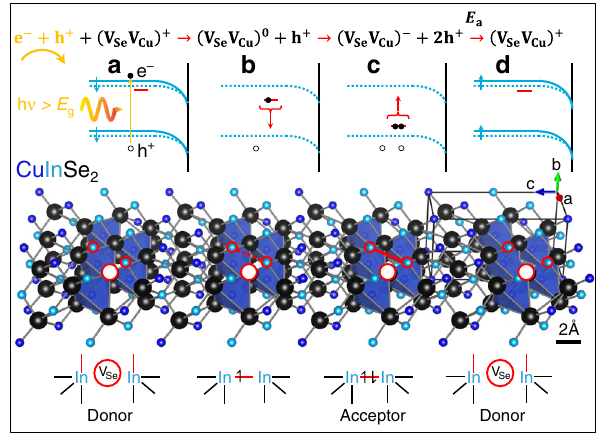
Fig. 8 Amphoteric (V Se V Cu ) divacancy as the culprit of the 200 meV defect. Simpli fi ed model of light-induced metastability observed in Cu-rich CIS subject to cyanide etching (leading to preferential removal of Se and Cu well below the surface). a Before light perturbation the divacancy is in its donor con fi guration (V Se V Cu ) + represented by the red state of the corresponding virtual hydrogen-like defect in the band diagram, and by the larger distance between the In atoms in the structural representation (bottom). b One photogenerated electron gets captured by the divacancy and partially occupies a bonding orbital between the two neighbouring In atoms, hence the divacancy assumes a neutral charge (V Se V Cu ) 0 . The bond being formed causes the In atoms to get closer, hence the energy level of the virtual hydrogen-like defect moves down. Electron trapping via chemical bond formation causes band fl attening (dashed lines). TR-SPV reveals a lower degree of band fl attening in Cu-rich CIS than in Cu-poor CIS, while PEC shows the slowly increasing photocurrent transient in Cu-rich CIS, instead of the decreasing photocurrent typical of Cu-poor CIS. c As the energy level gets closer to the valence band maximum, one electron is captured, leading to the full conversion of the divacancy into the acceptor state (V Se V Cu ) − and to the largest structural displacement with respect to the donor con fi guration. d The complete In – In bond formation at point c entails a sizable activation energy for the cleavage of the acceptor via capture of two holes, hence the time constant associated to the surface charge reconstruction is on the order of tens of minutes at room temperature, as observed in